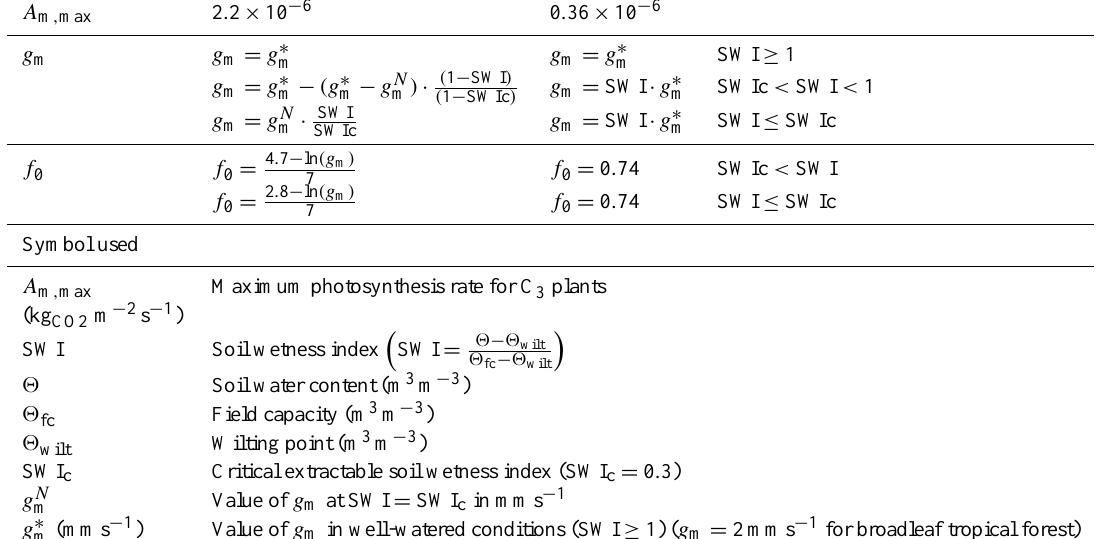
Table 3. ISBA CC modifications: photosynthesis and transpiration PS version.